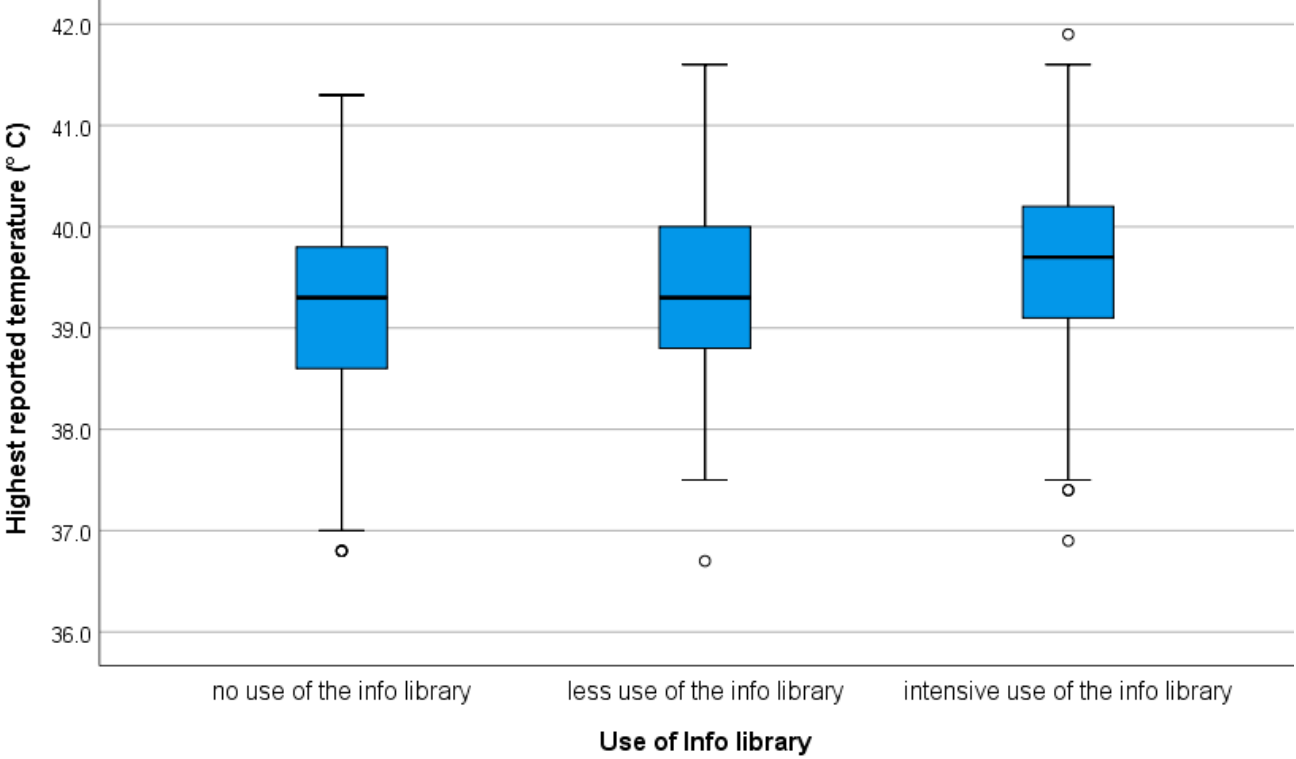
Figure 2. Use of the Info Library and highest reported temperature (circles are outliers). Table 2. Use of the Info Library depending on the status of parents, education, age, and